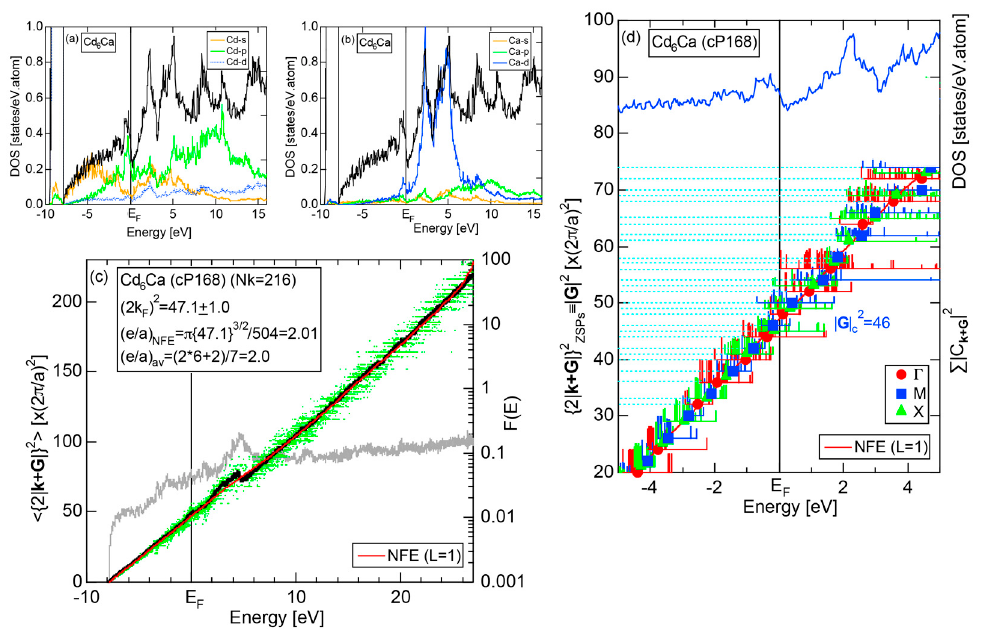
Figure 45. ( a ) Cd- and ( b ) Ca-pDOSs; ( c ) Hume-Rothery plot and ( d ) FLAPW-Fourier spectra at symmetry points Γ , M, X of simple cubic Brillouin zone for Cd 6 Ca (cP168) [11]. A blue curve in ( d ) indicates the